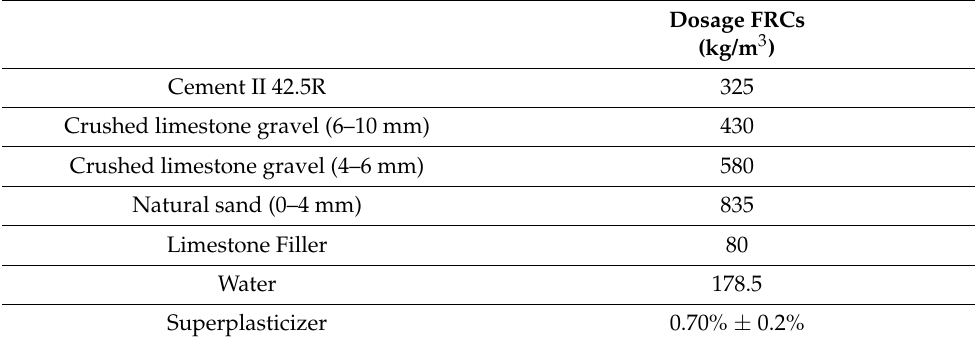
Table 1. FRC dosages used in the present